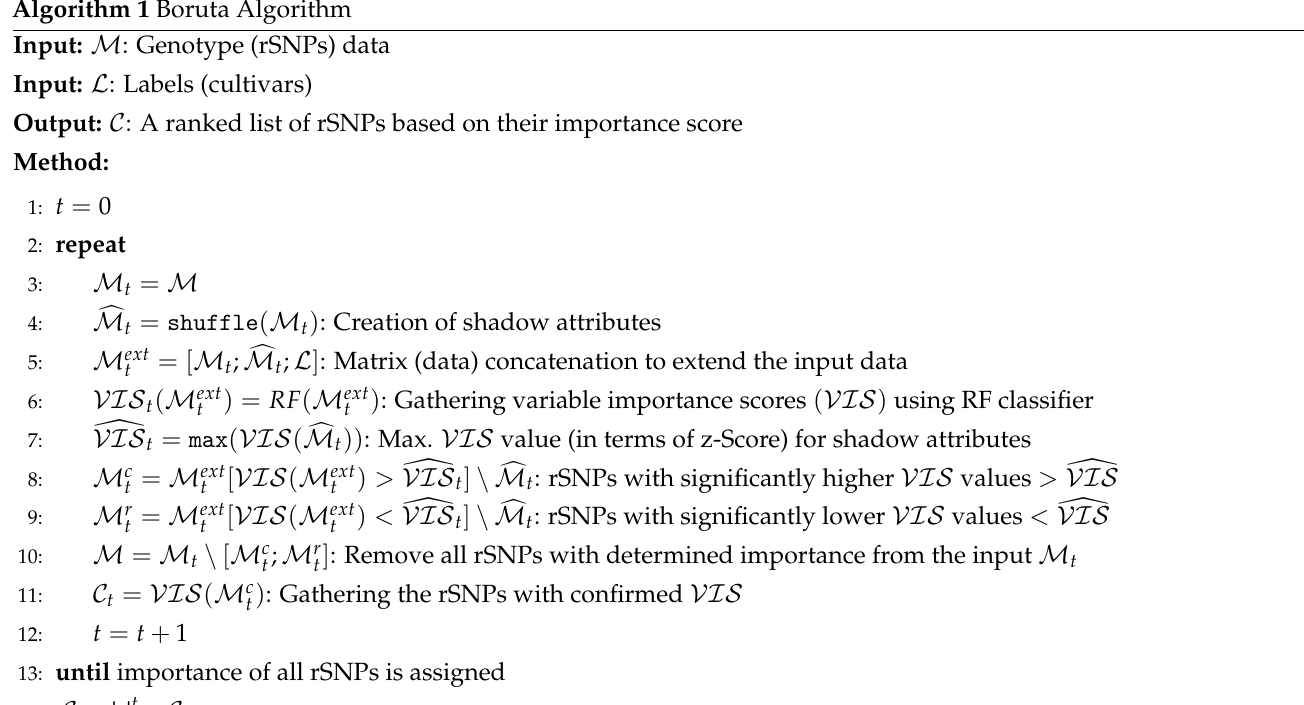
Algorithm 1 Boruta